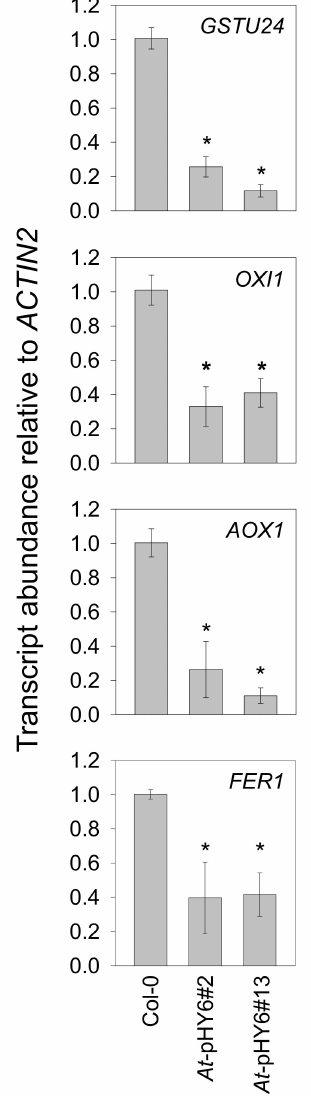
Figure 5. Transcript abundance of oxidative stress marker genes were suppressed in the RNAi plants compared with Col-0 at 48 hpi. Transcriptional expression is shown relative to the reference gene ACTIN2 . Values shown indicate means of four biological replicates. Asterisks indicate that values are significantly different from those of Col-0. * p <